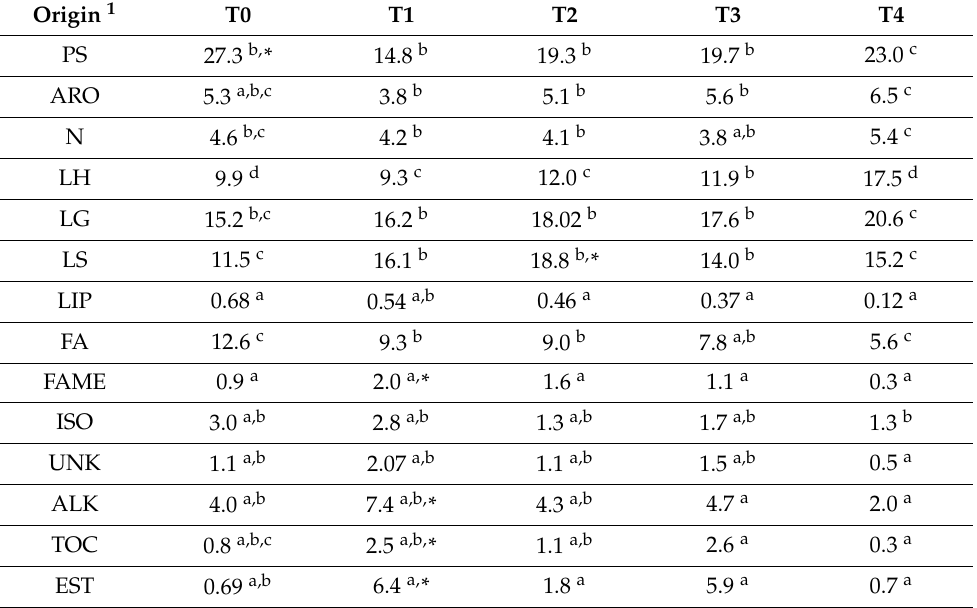
Table 1. Relative average abundances (%) of the main pyrolysis compounds grouped according to their chemical nature and probable biogenic origin.